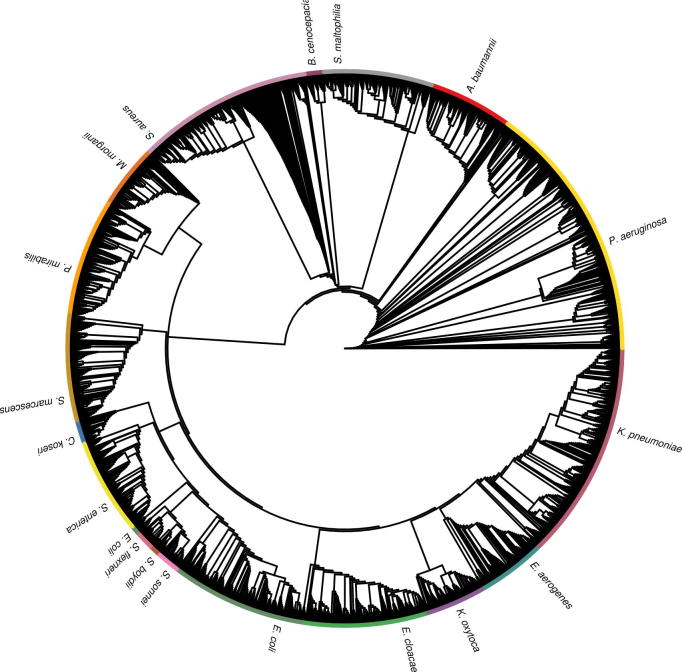
Phylogenetic tree of the isolates The phylogenetic tree of the isolates built using RAxML and multiple sequence alignments of the best hits of the essential genes found in at least 99% of the isolates. The tree tips are colored relative to the isolate species taxon.